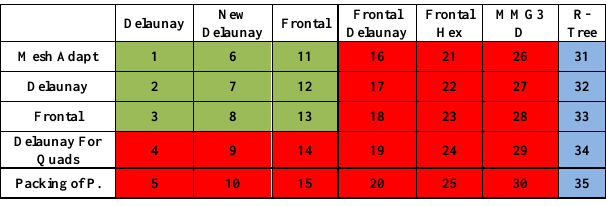
Table 2. Meshing results in terms of usability. Green =